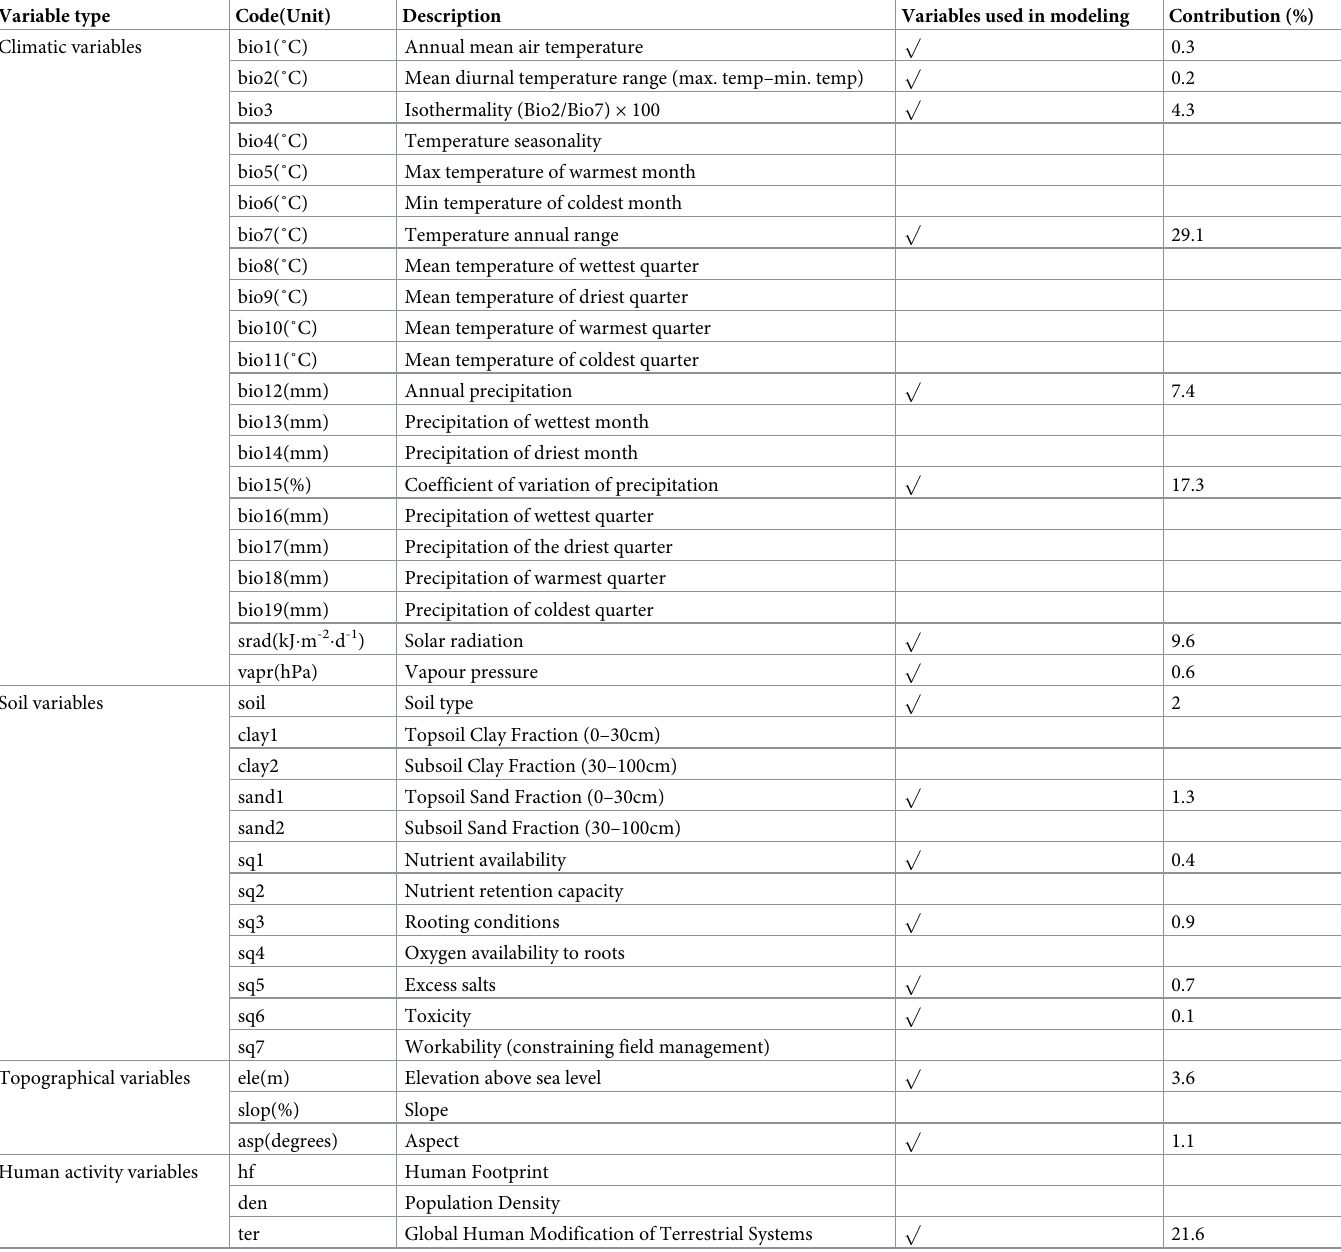
Table 1. Environmental variables used or not used in model, along with the respective relative contribution scores from the fitted MaxEnt